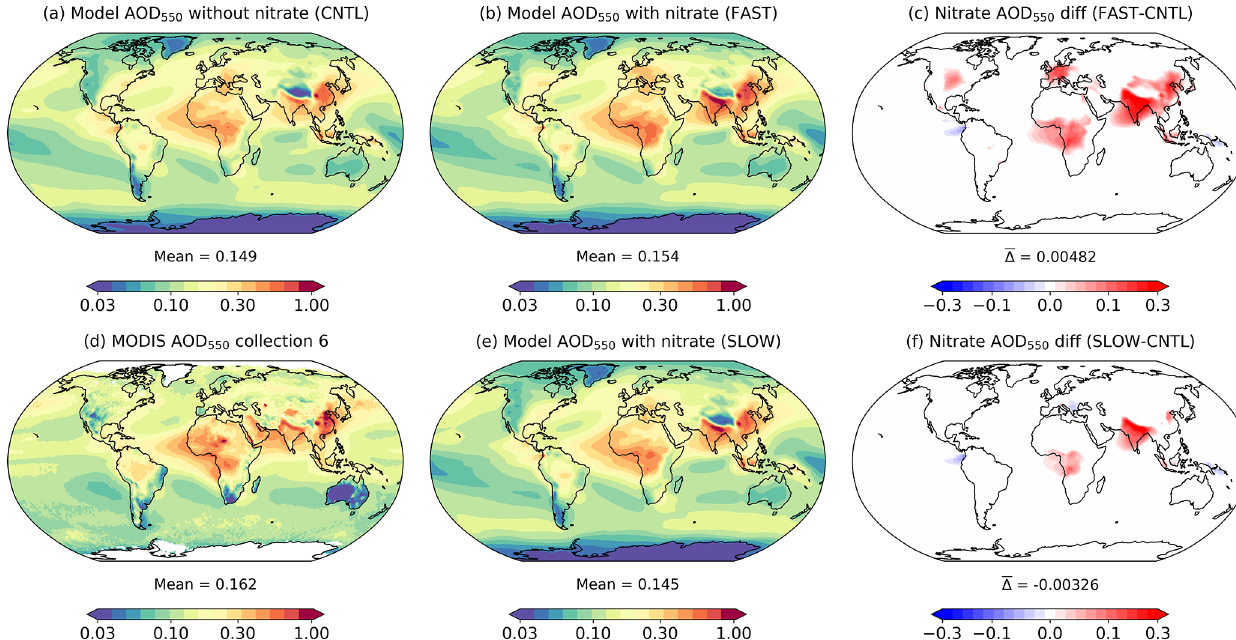
Figure 9. Annual-mean and column-integrated 550nm aerosol optical depth (AOD 550 ) in the CNTL, FAST, and SLOW simulations and from MODIS Collection 6 satellite observations. Panels (c) and (f) show the difference between the FAST and CNTL and SLOW and CNTL simulations